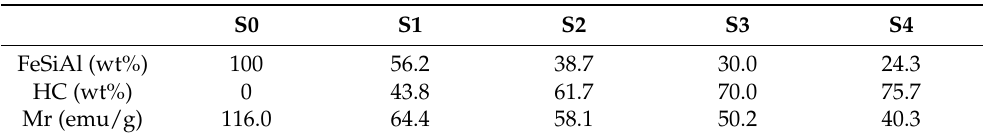
Figure 5. VSM patterns of the FeSiAl and FeSiAl@HC S0 − S5 samples. Table 1. Calculated mass ratio values of saturation magnetization (Mr) of the FeSiAl and FeSiAl@HC samples.